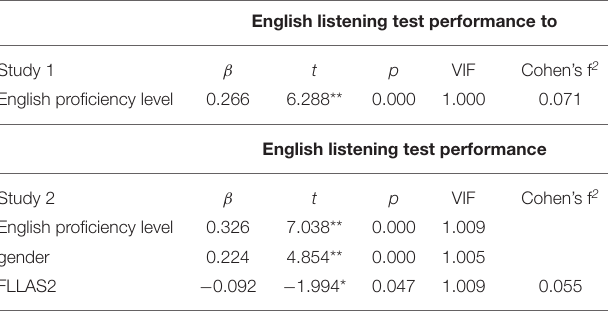
TABLE 5 | Regression coefficients and significance of predictors for english listening test performance (FLLAS, English proficiency and gender as independent